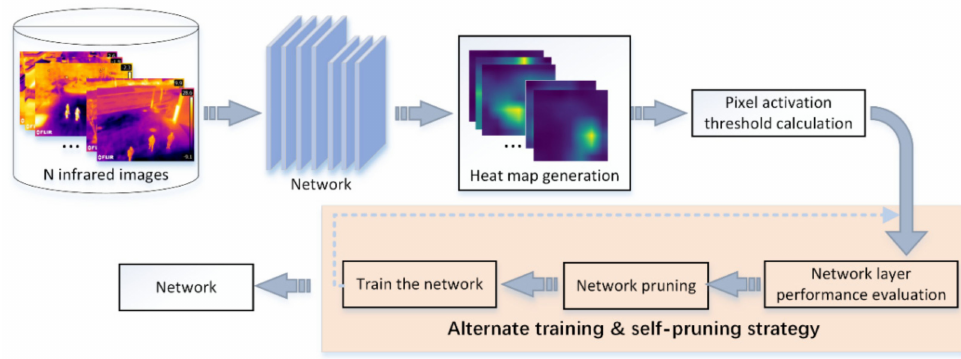
Figure 2. Network pruning method.